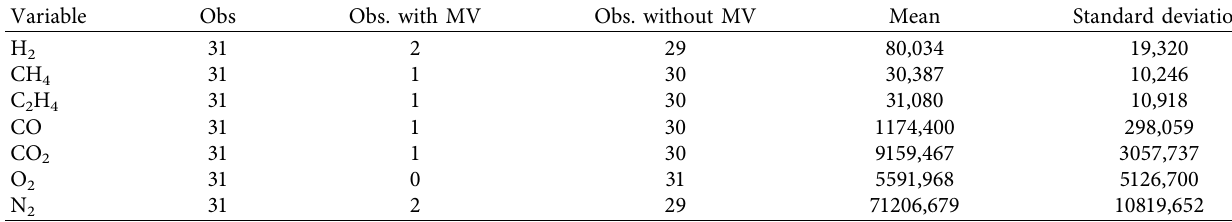
Table 3: Statistical data before any imputation.